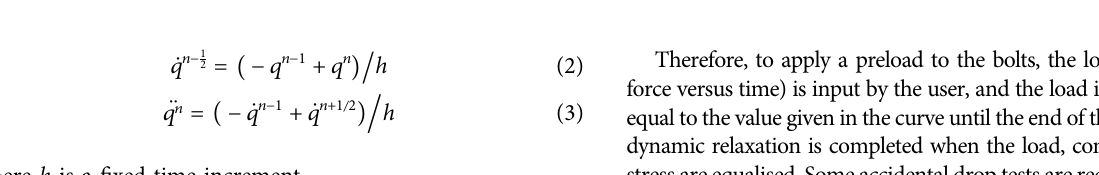
Frontiers in Energy Research |